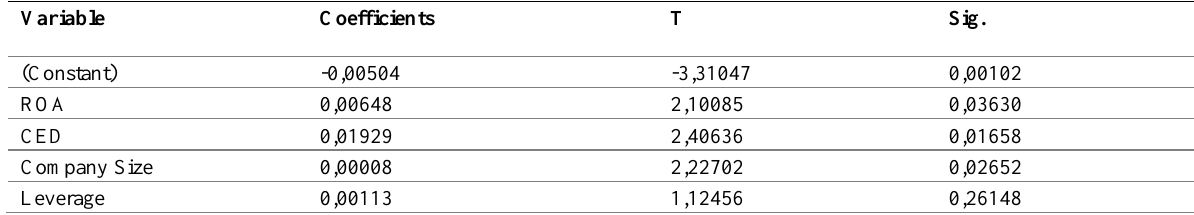
Table 4: Results of regression analysis without